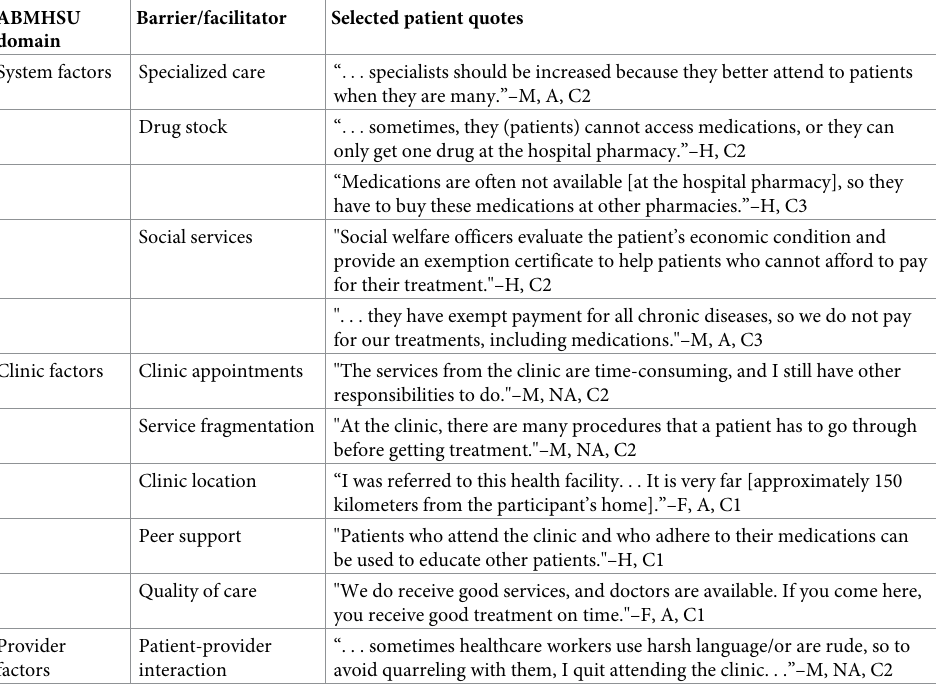
Table 4. Environmental barriers/facilitators to clinic attendance and medication adherence organized according to the domains of the Andersen’s behavioral model of health services